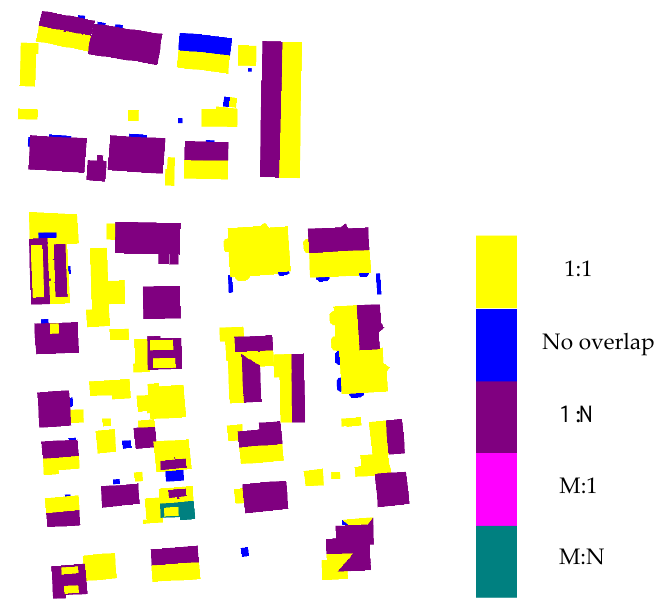
Figure 20. Topological differences between the 3D roof planes (results: Reference).